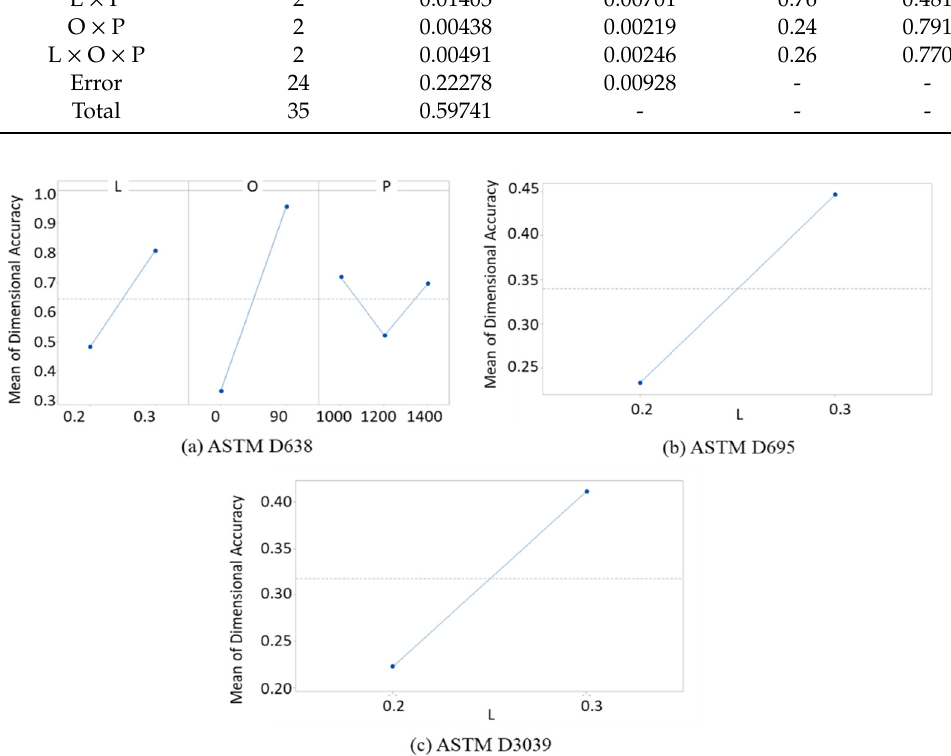
Figure 7. Main effect plots of the significant factors for dimensional accuracy. ( a ) ASTM D638; ( b ) ASTM D695; ( c ) ASTM D3039.